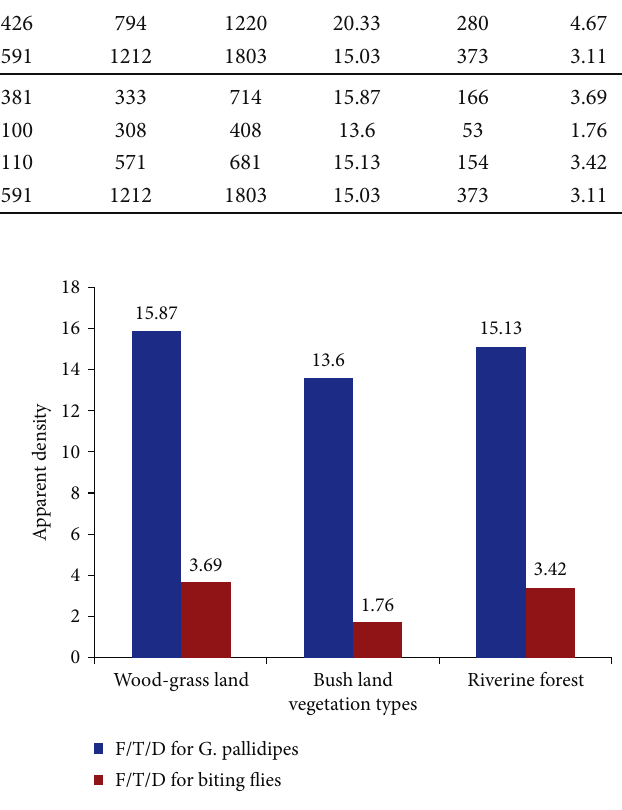
Figure 2: Apparent density based on vegetation types in the study